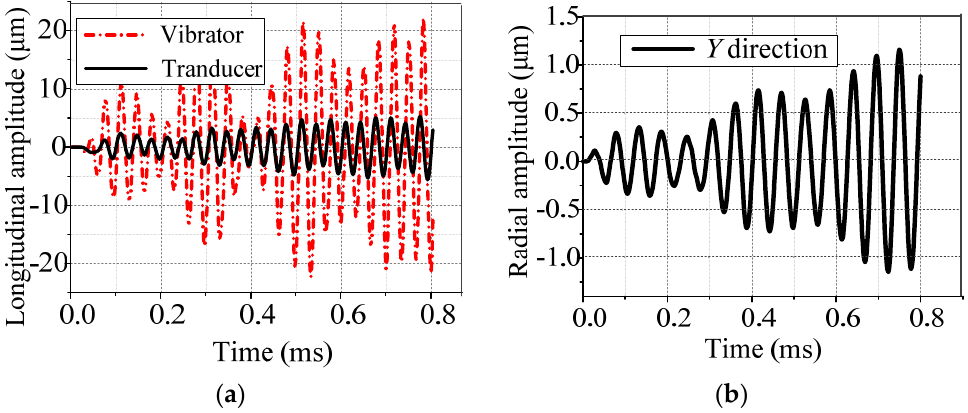
Figure 9. Transient analysis of the power-superimposing vibration system driving by sinusoidal voltages without phase difference ( a ) Longitudinal amplitude of vibrator and transducers; ( b ) Radial amplitude in Y direction.